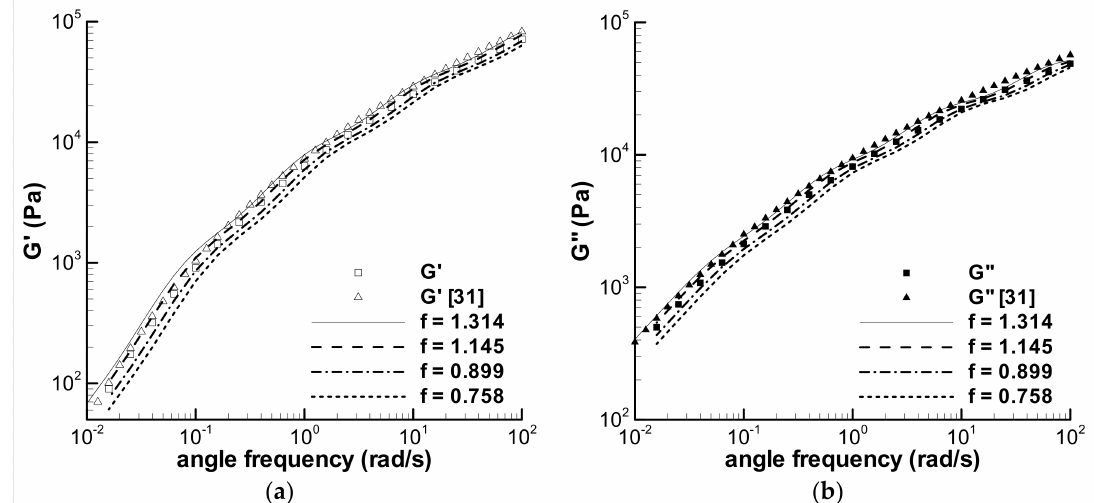
Figure 13. Calculated frequency sweep in small amplitude oscillatory shear mode using some spectra with f in Table 4, the present G (cid:48) and G” experimental data (square symbol) and the reported G (cid:48) and G” [31] (triangle symbol). ( a ) G (cid:48) , and ( b )